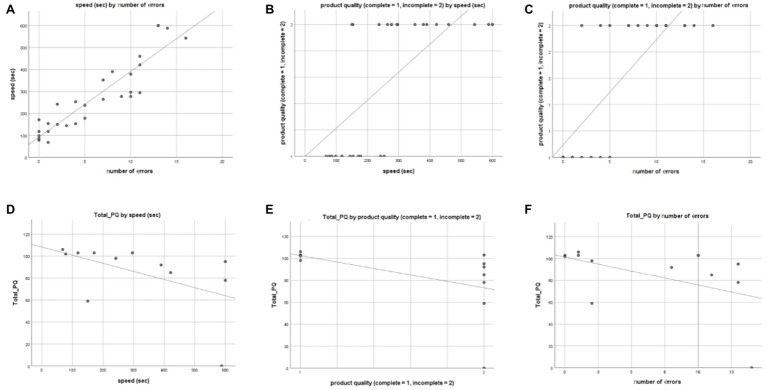
Scatter plots of statistically significant correlations. Task completion speed x number of errors (A), product quality x task completion speed (B), product quality x number of errors (C), total PQ score x task completion speed (D), total PQ score x product quality (E), and total PQ score x number of errors (F). Linear relationships are indicated.